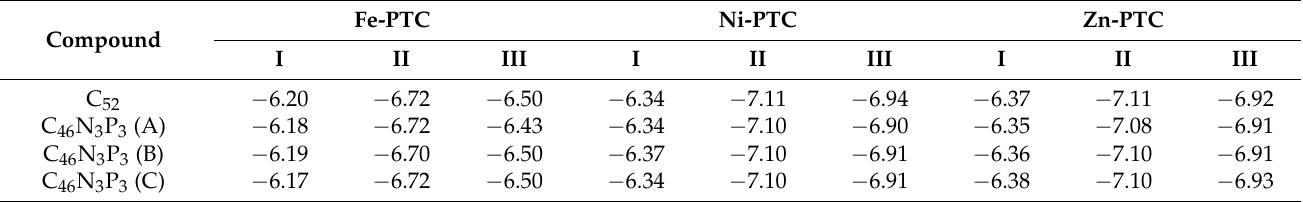
Table 17. The final Lamarckian genetic algorithm docked state: best binding affinities of ligands with the nanostructures (kcal mol − 1